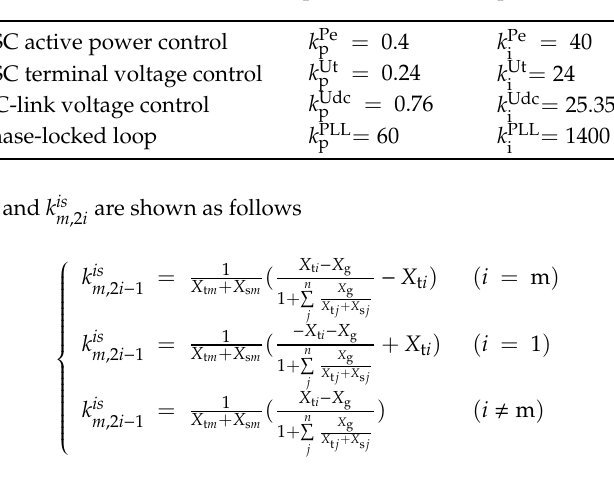
Table A2. Controllers parameters values